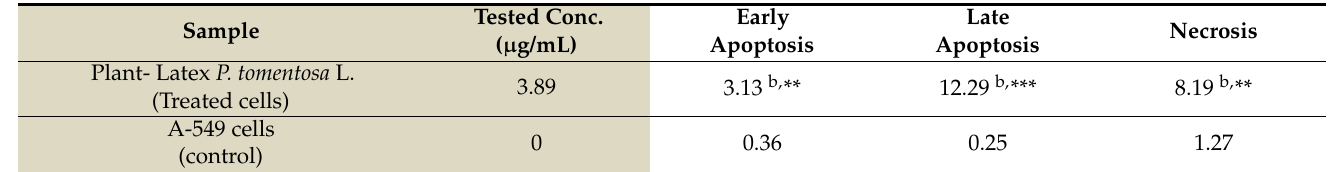
Table 2. The effect of the IC 50 of plant latex of P. tomentosa L. on the percentages of apoptotic and necrotic cells of the A-549 cell line a